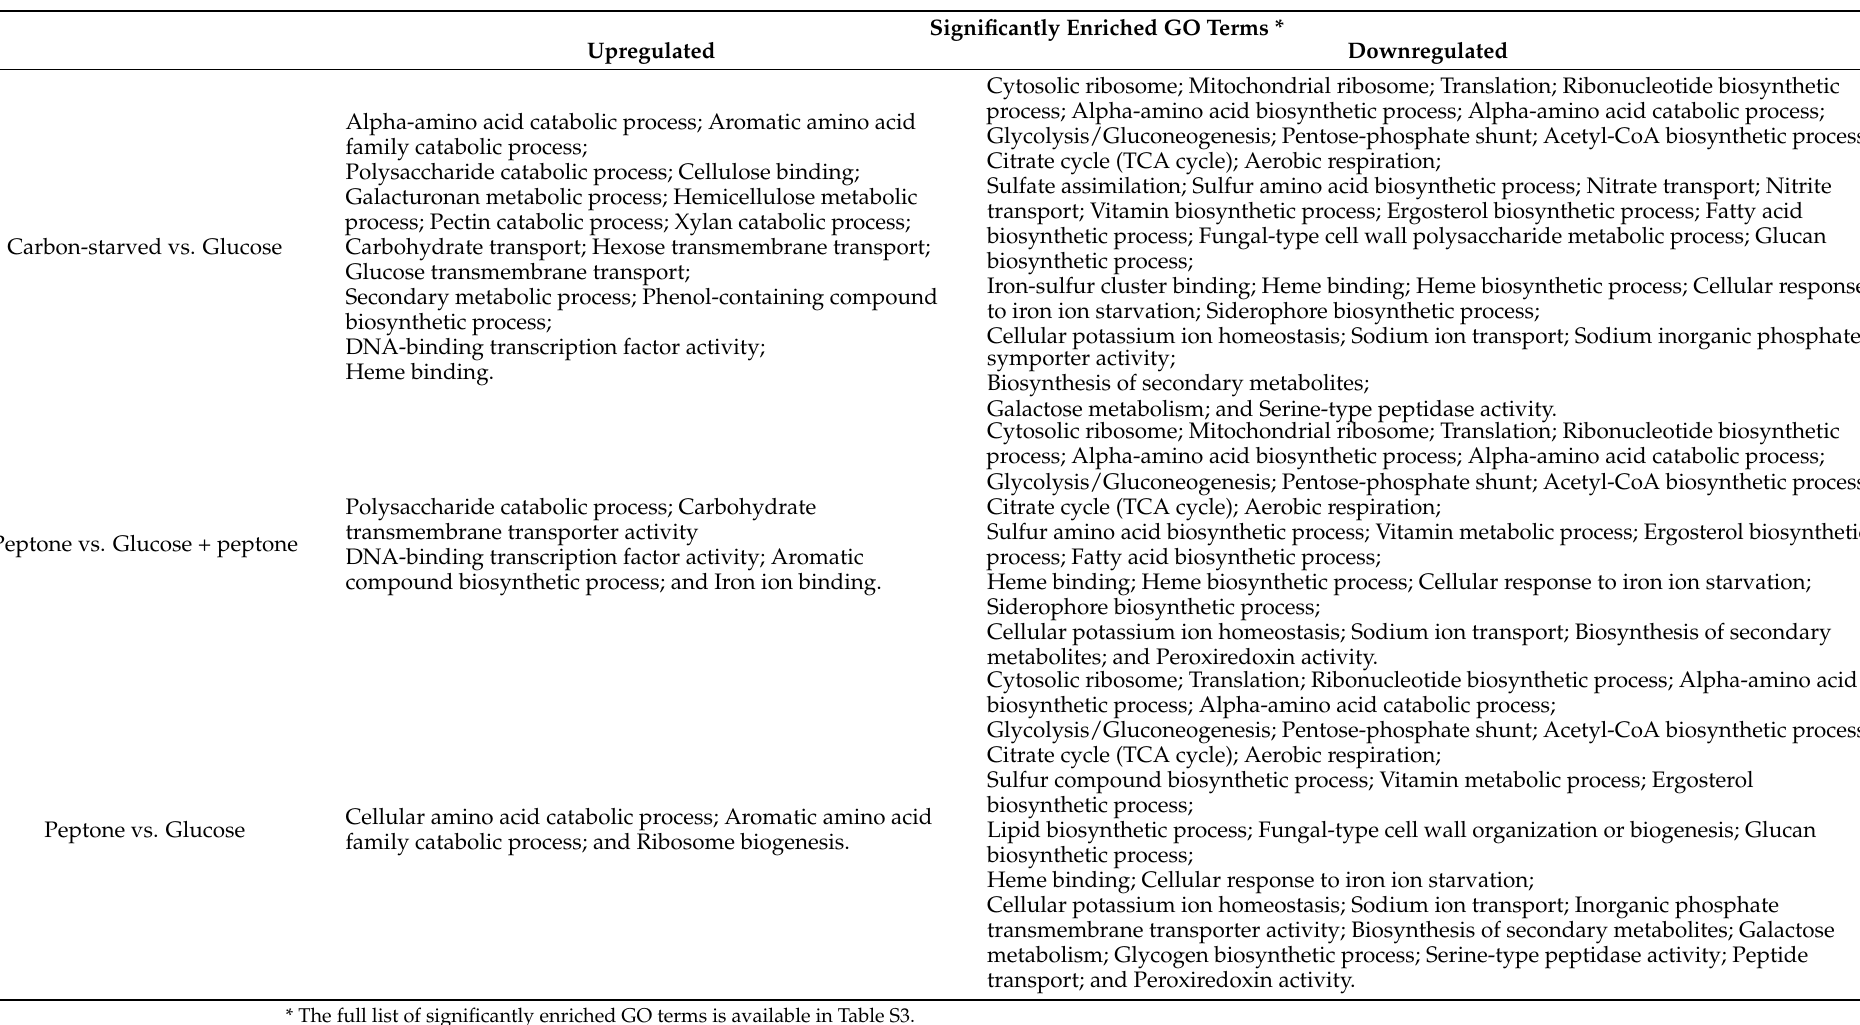
Table 1. GO terms enriched significantly in the upregulated or downregulated gene sets in glucose-depleted cultures. Significantly Enriched GO Terms * Upregulated Downregulated